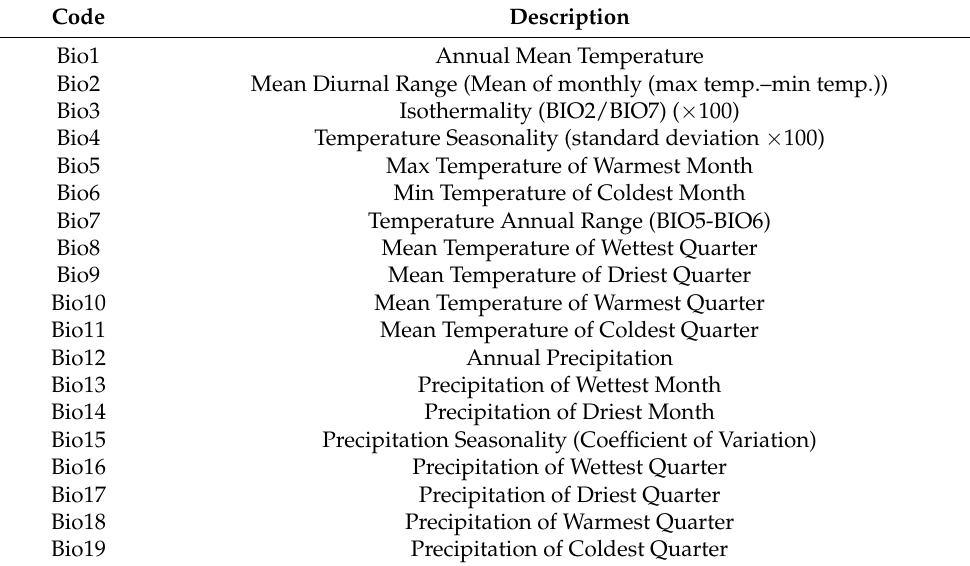
Table 1. Bioclim